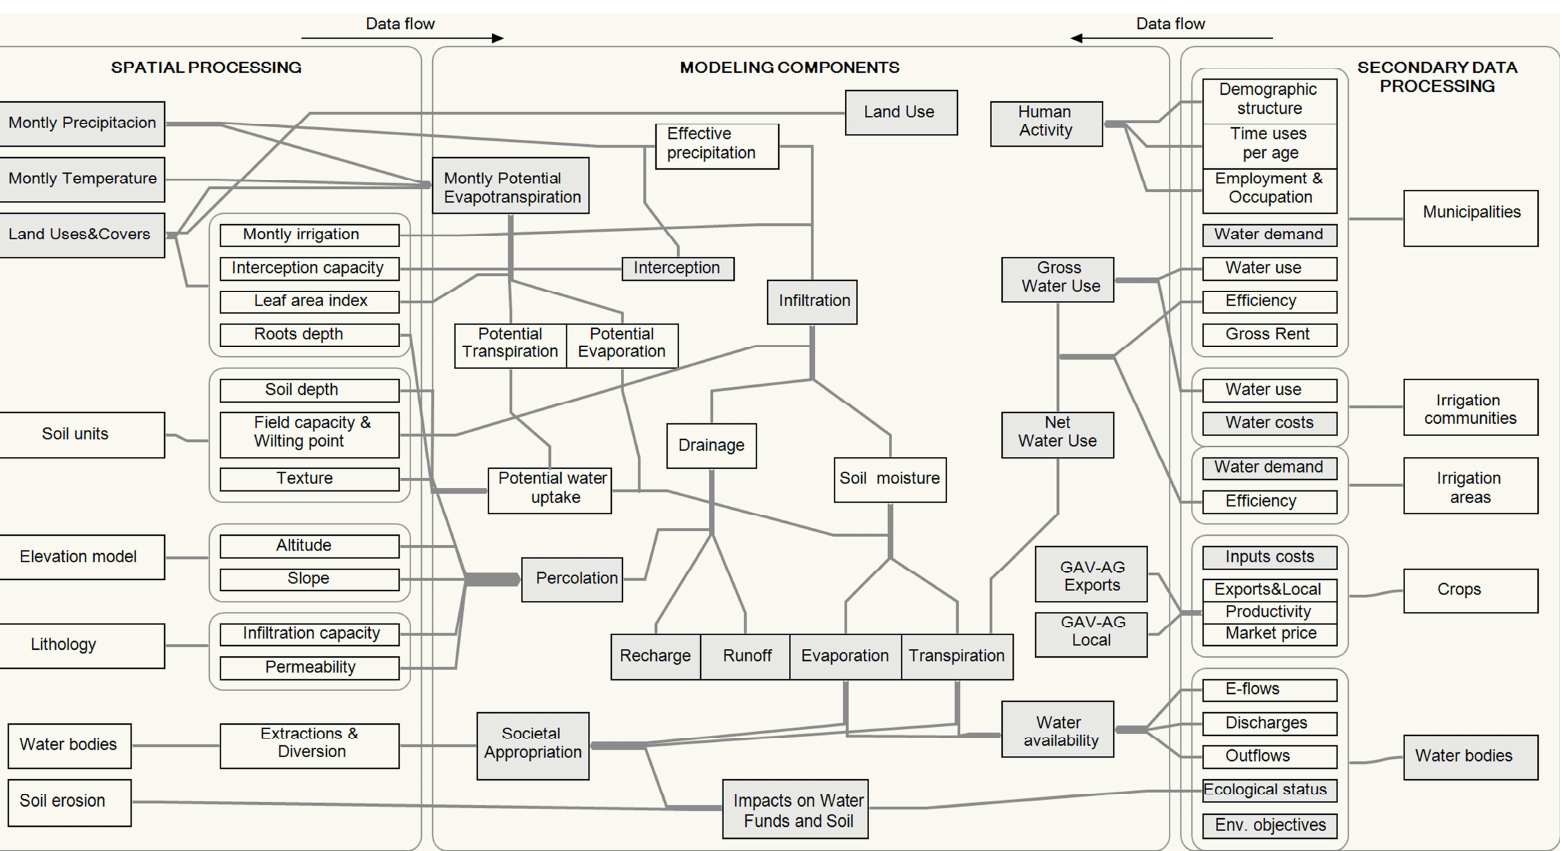
Figure 2 - Conceptual scheme for water grammar